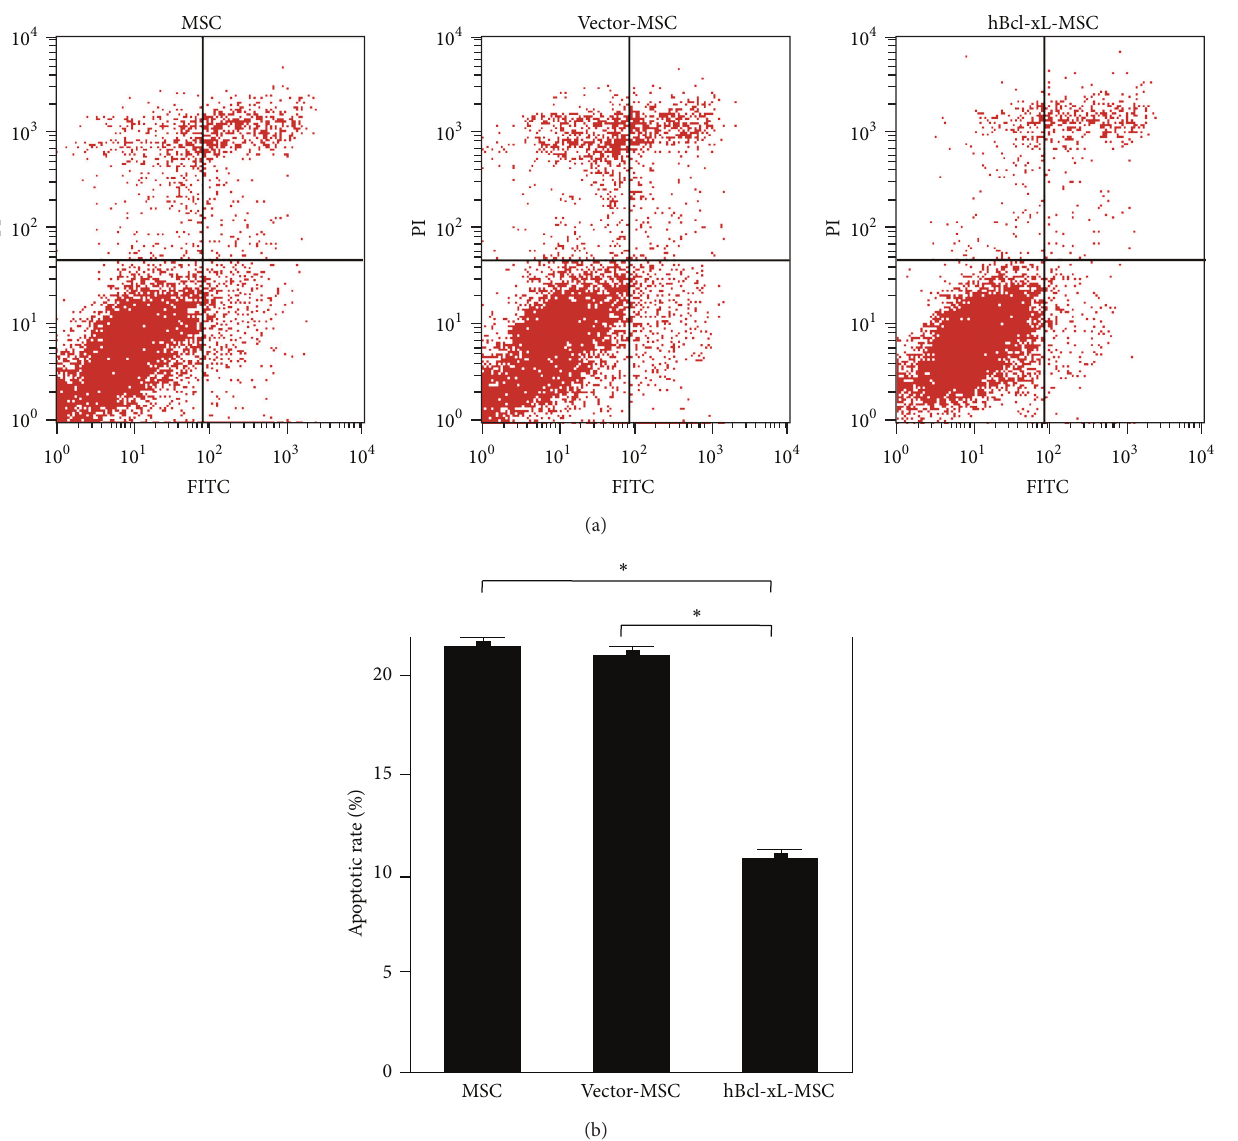
Figure 3: Antiapoptotic effect of hBcl-xL-MSCs in vitro . (a) Annexin V-FITC/PI apoptosisassay of wild type MSCs, vector-MSCs, and hBcl- xL-MSCs. Cells were seeded into T25 flasks and were cultured in medium with 200 𝜇 M H 2 O 2 at 37 ∘ C for 4 hours. The resuspended cells were incubated with Annexin V-FITC and PI for 15min and checked with a BD FASAria Cell Sorter. (b) The apoptotic rate was presented as mean ± SD ( 𝑛 = 3 , ∗ 𝑃 < 0.05 ). PI: propidium